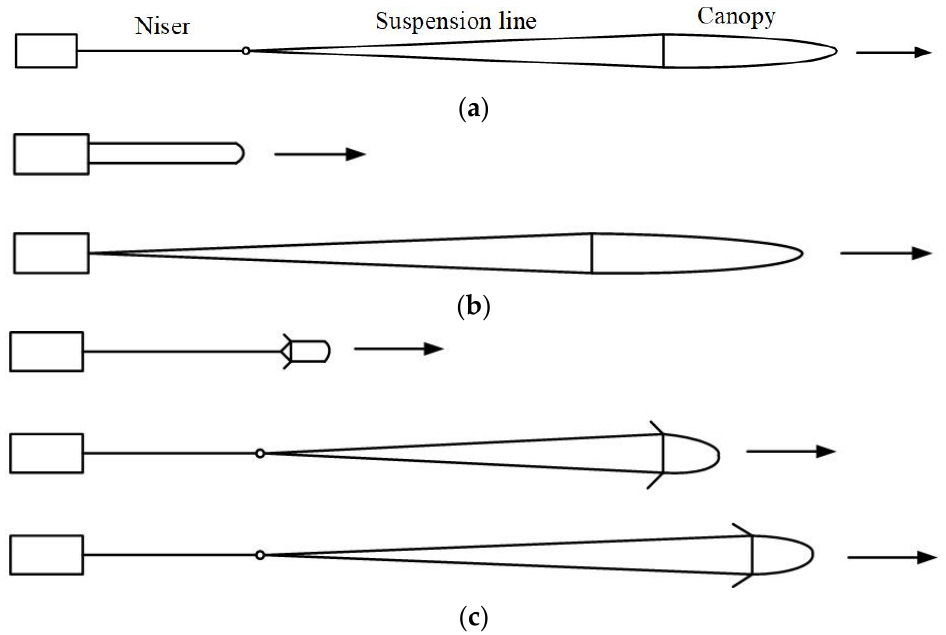
Figure 2. Deployment procedures. ( a ) The final state of a parachute deployment phase ( b ) Canopy- first deployment ( c ) Lines-first deployment.